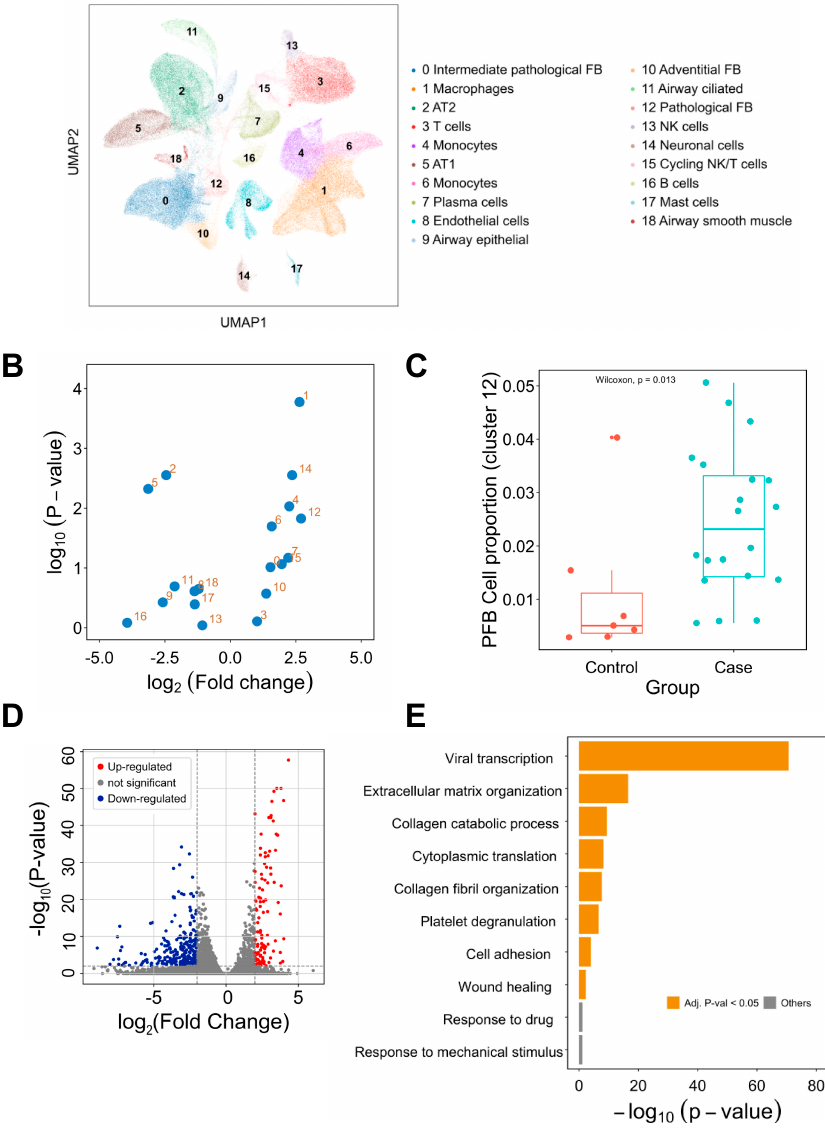
Figure 2. Single-cell transcriptome analysis of the lung tissues in COVID-19 cases. ( A ) Single-cell analysis of 116,314 cells from lung tissues. Nineteen cell clusters were identified and annotated based on the cell (sub)types provided by the literature [7]. ( B ) Visualization of the proportional difference of cells between COVID-19 patients and healthy controls. ( C ) Comparison of cluster 12 (PFBs) proportion between COVID-19 patients and healthy controls. ( D ) Differentially expressed gene analysis of cluster 12. Up-regulated and down-regulated genes are highlighted in red and blue, respectively. ( E ) Functional enrichment analysis of the differentially expressed genes. Enriched biological processes are shown in a bar plot. pFB: pathological fibroblast. PCPF: post-COVID-19 pulmonary fibrosis.